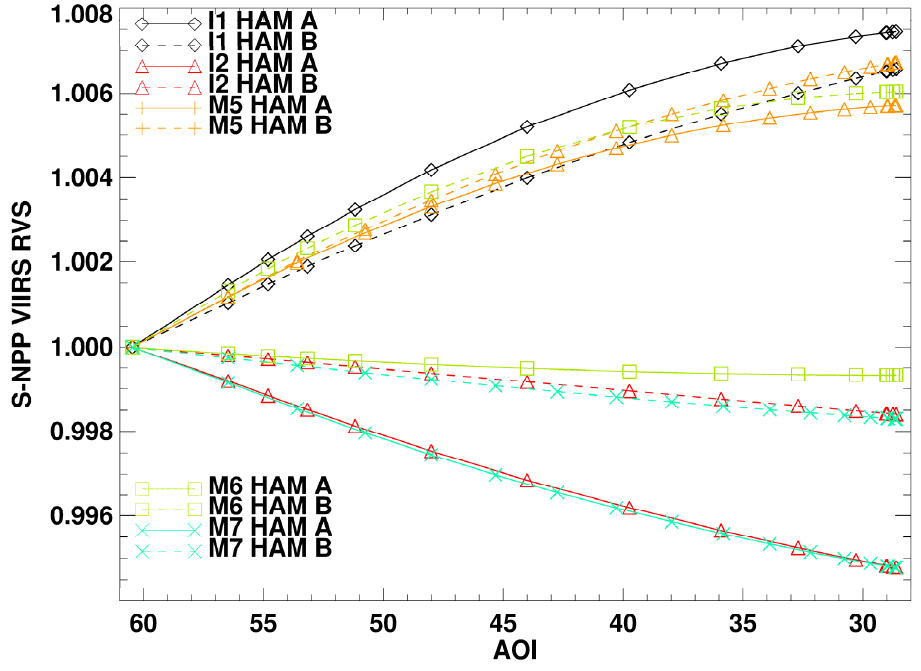
Figure 12. Band-averaged RVS for S-NPP VIIRS RSBs from the SV AOI to the end of scan AOI for bands I1, I2 and M5–M7.